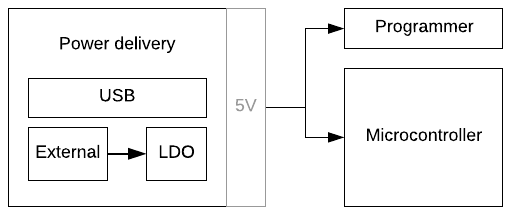
Figure 1. Arduino Uno power flow: power delivery either through USB or an external 12 V power supply, converted to a 5 V power rail powering both the always-on programmer and